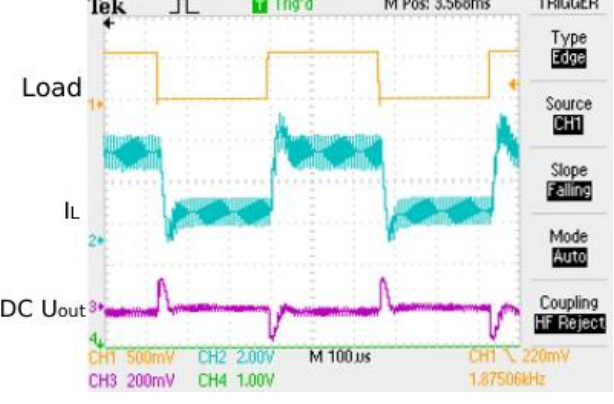
Figure 9. Step change in output current